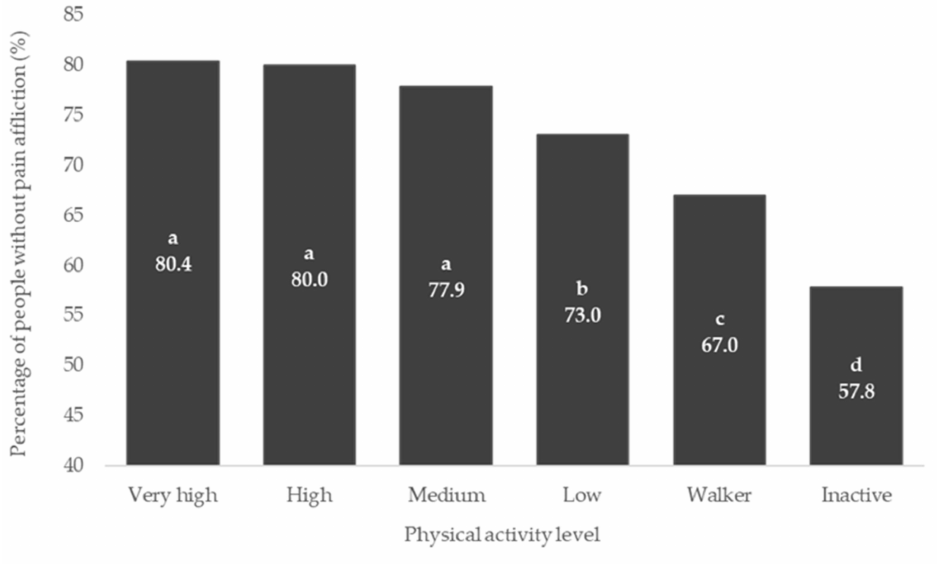
Figure 2. Percentage of people in the general population without pain effect, according to physical activity level.